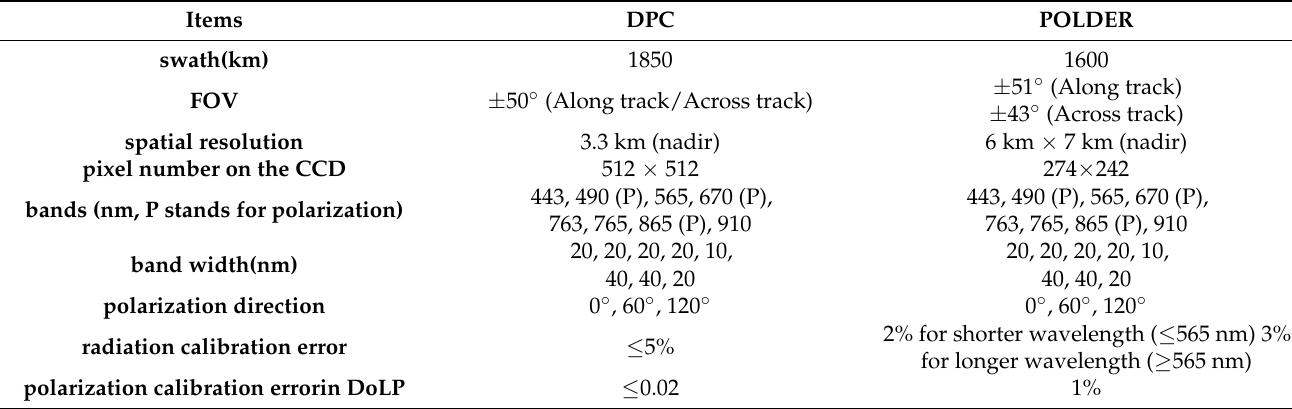
Table 1. The performance specifications of the DPC and